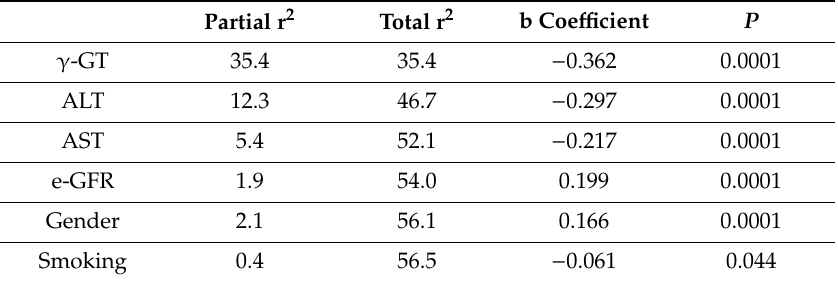
Table 3. Multiple linear regression models for FBF maximal response to